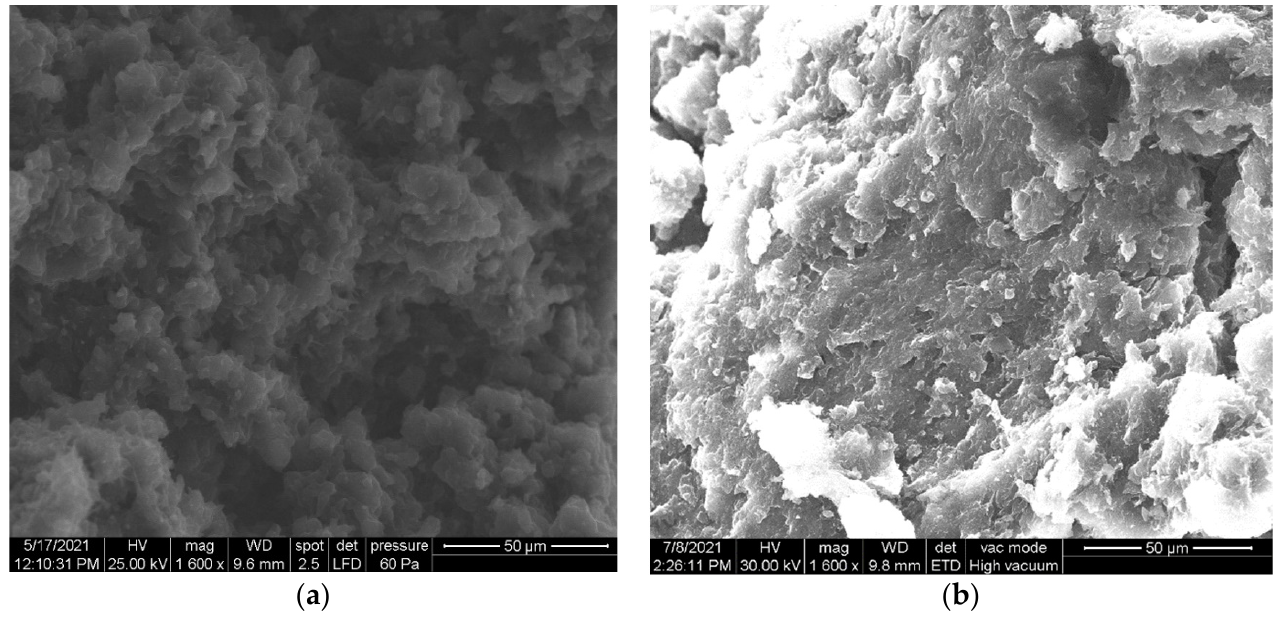
Figure 1. Scanning electron microscopy (SEM) images of: ( a ): GRQD/CNT; ( b ): Cu/GRQD/CNT.